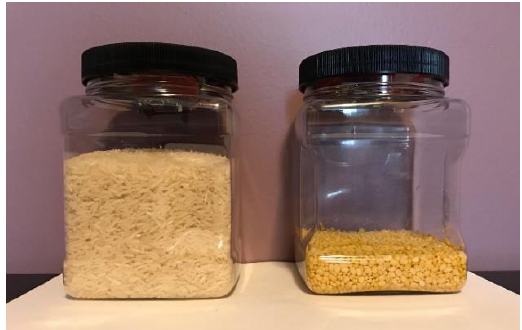
Figure 7. Smart canisters containing rice (left) and lentils (right).